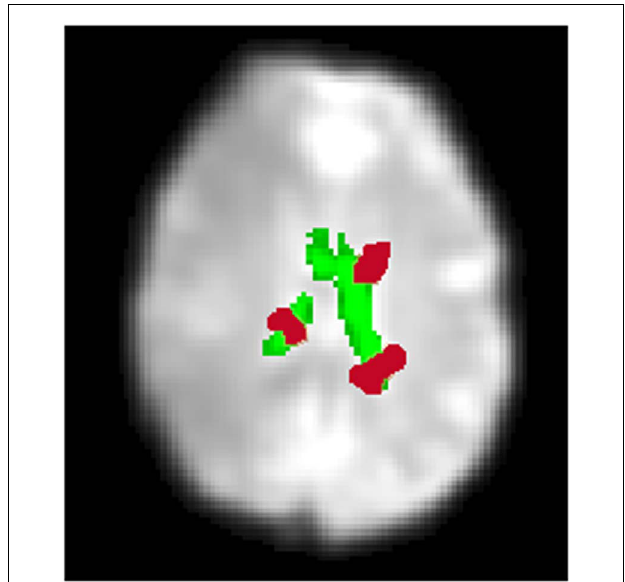
FIGURE 4 |An overview of identifying CSF artifact . A CSF mask automatically created by an SPM sub-routine, “New Segment” is shown in green (single slice shown).This is overlaid onto a mean functional image. In red are an illustration of contiguous clusters which overlap the CSF mask. If the volume of activity overlapping the CSF mask is 10% or greater, the IC is labeled High CSF Activity ( Low CSF Activity otherwise).The CSF activity for a particular IC calculated over all slices, not just the slice shown